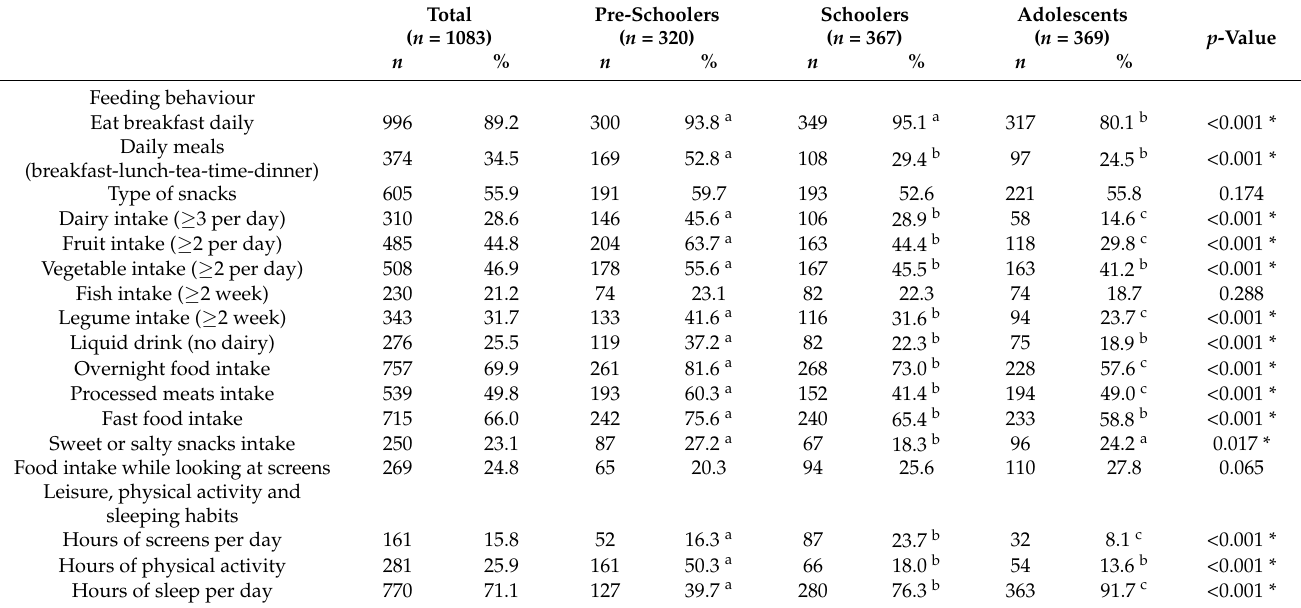
Table 2. Percentage of compliance with the Healthy Lifestyles recommendations for children and